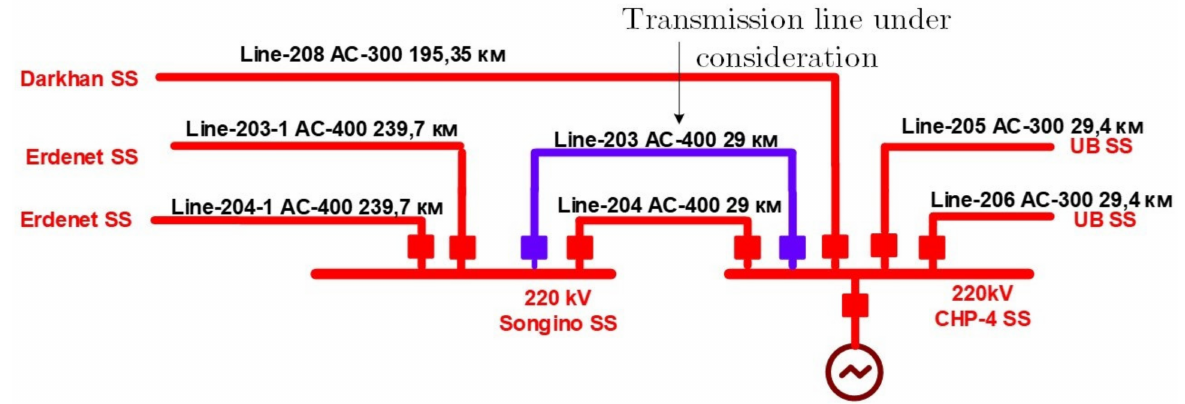
Figure 22. Details of the location of Line-203 in the Mongolian Power System.